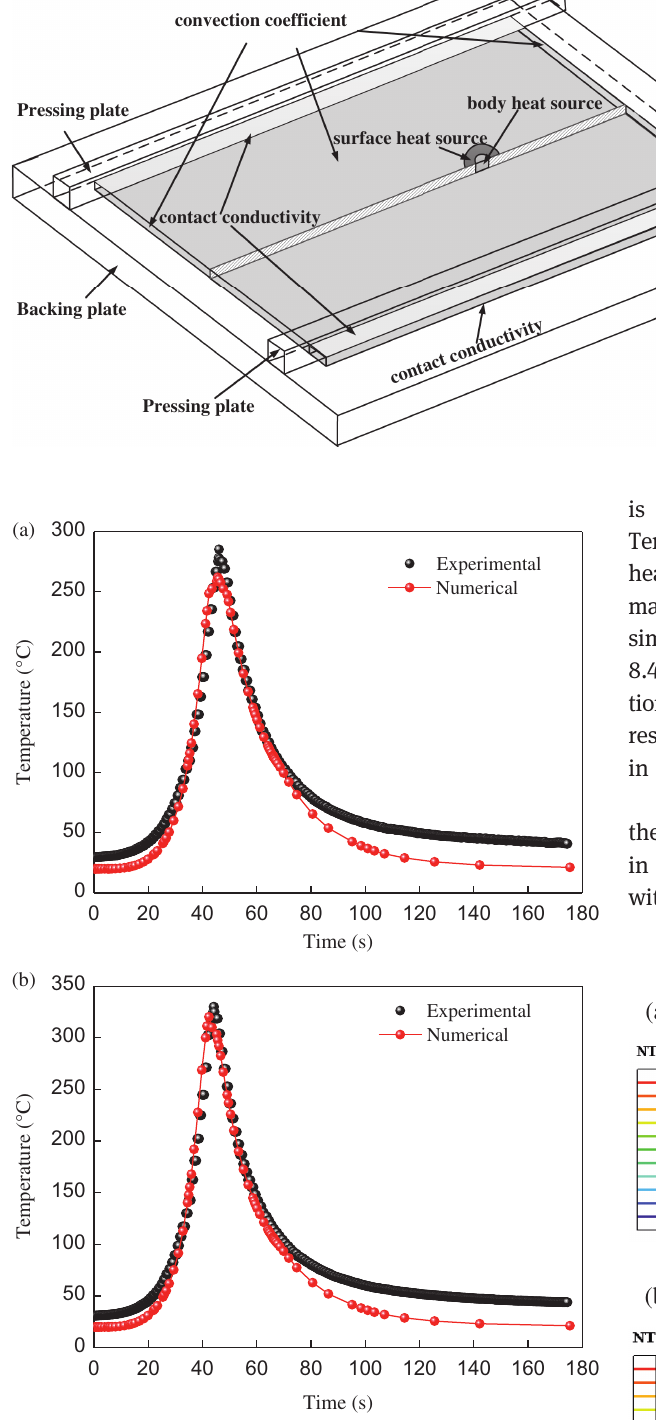
Figure 5: Temperature histories of conventional cooling aided FSW: (a) P1 and (b) P2.